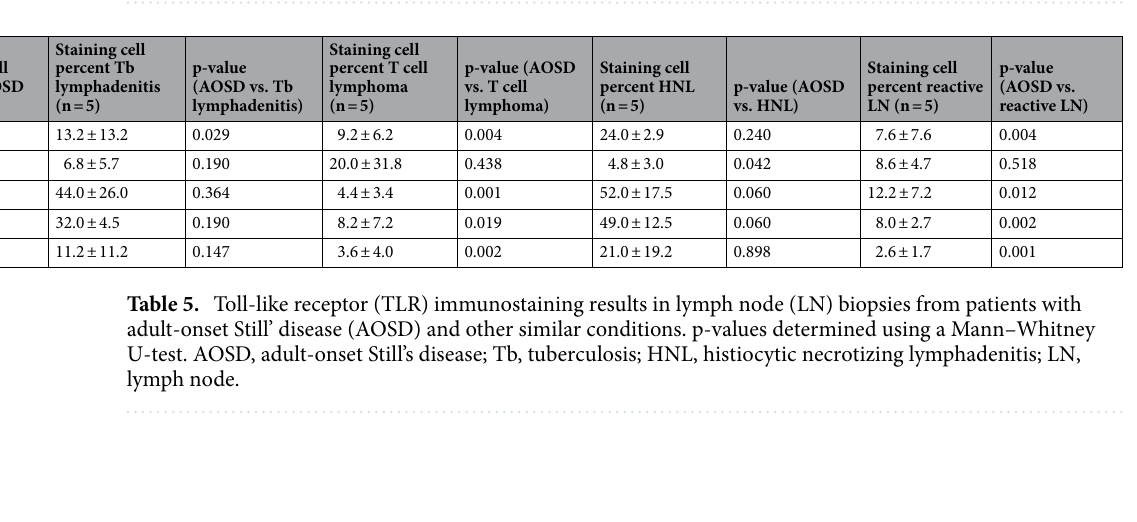
Figure 3. Toll-like receptor (TLR)1 ( A–D ), TLR2 ( E–H ), TLR4 ( I–L ), TLR7 ( M–P ), and TLR9 ( Q–T ) expression in skin biopsies of patients with adult-onset Still’s disease (AOSD) ( A,E,I,M,Q ), eczema ( B,F,J,N,R ), psoriasis ( C,G,K,O,S ) and healthy controls (HCs) ( D,H,L,P,T ). Original magnification, × 100 or × 400. TLR2 was more frequently expressed in the skin of patients with AOSD than in that of HCs. TLR9 was more frequently expressed in the skin of patients with AOSD than in that of patients with eczema or psoriasis, and HCs.